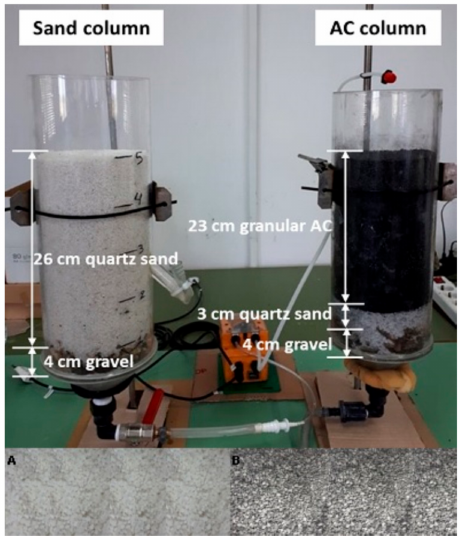
Figure 1. The laboratory-scale sand-activated carbon (AC) system consisting of quartz sand (A) and granular AC (B) used for the tertiary treatment and detoxification of a biologically treated fungicide-containing wastewater.